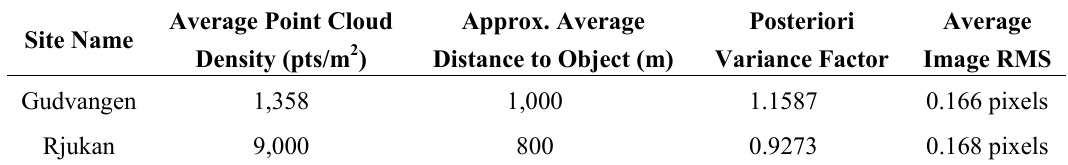
Table 2. Detailed breakdown of image and 3D data collected at the Gudvangen and Rjukan sites in